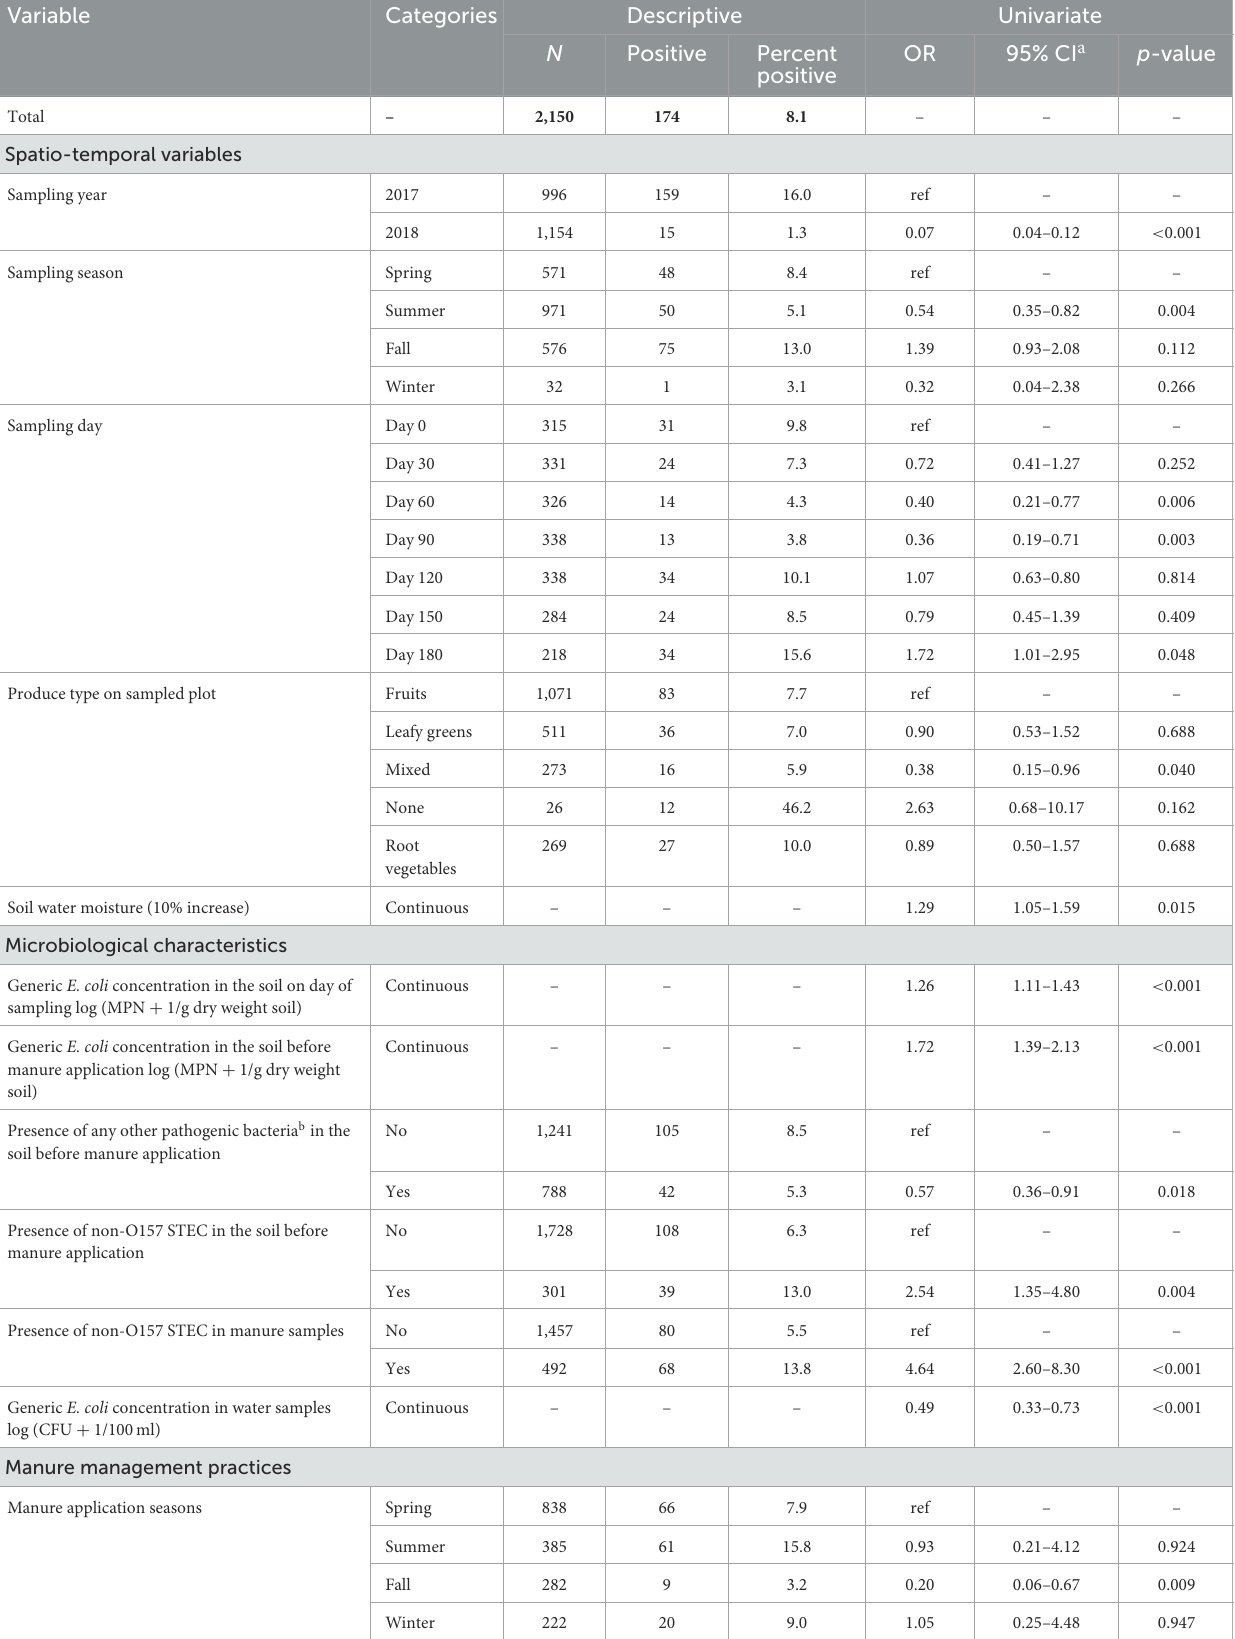
TABLE 1 Univariable analysis, using a mixed-effect logistic regression model, of the factors (sample-level, time-dependent and farm questionnaire variables) that influence the likelihood of non-O157 STEC presence in soil samples amended with untreated manure in certified organic farms.